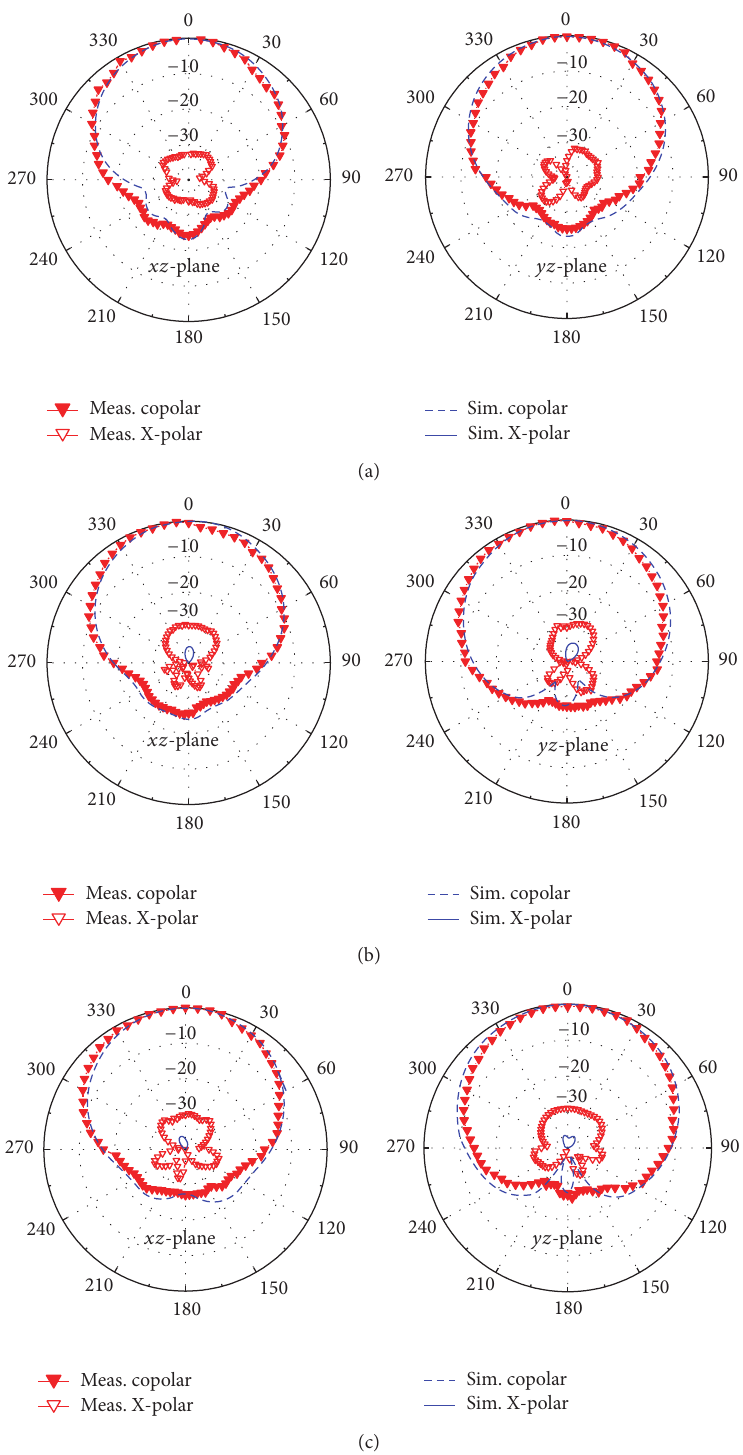
Figure 13: Radiation patterns for Port 1 of the proposed antenna (a) 2 GHz, (b) 2.4 GHz, and (c) 2.8